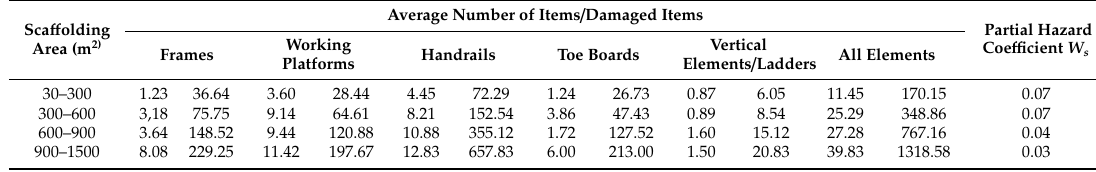
Table 9. Damage with regards to the sca ff olding surface